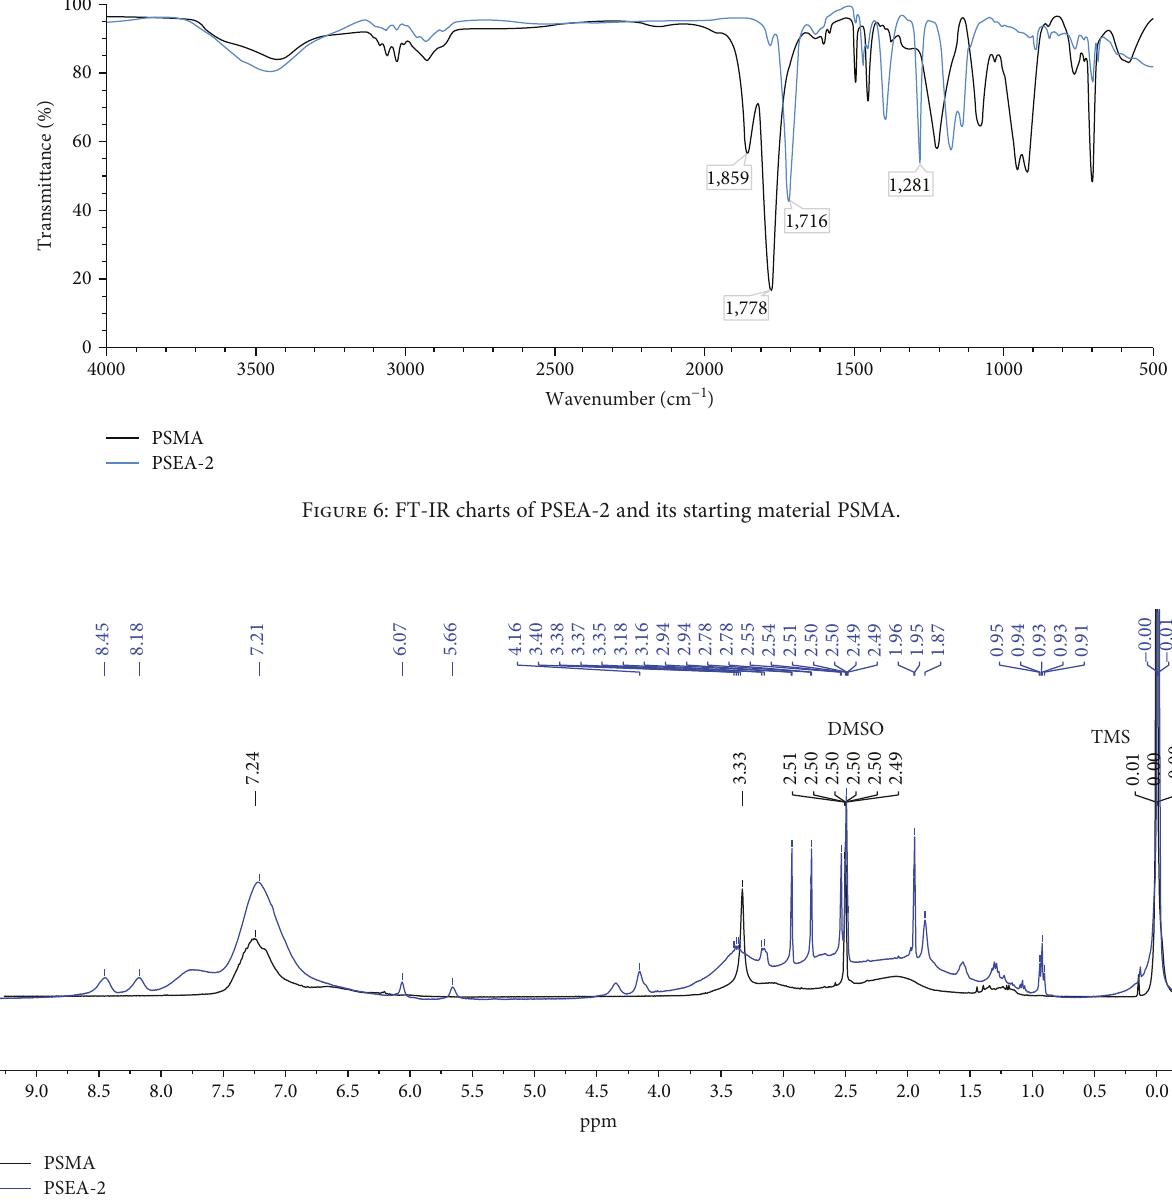
Figure 7: 1 H NMR diagrams of PSEA-2 and its starting material PSMA in d